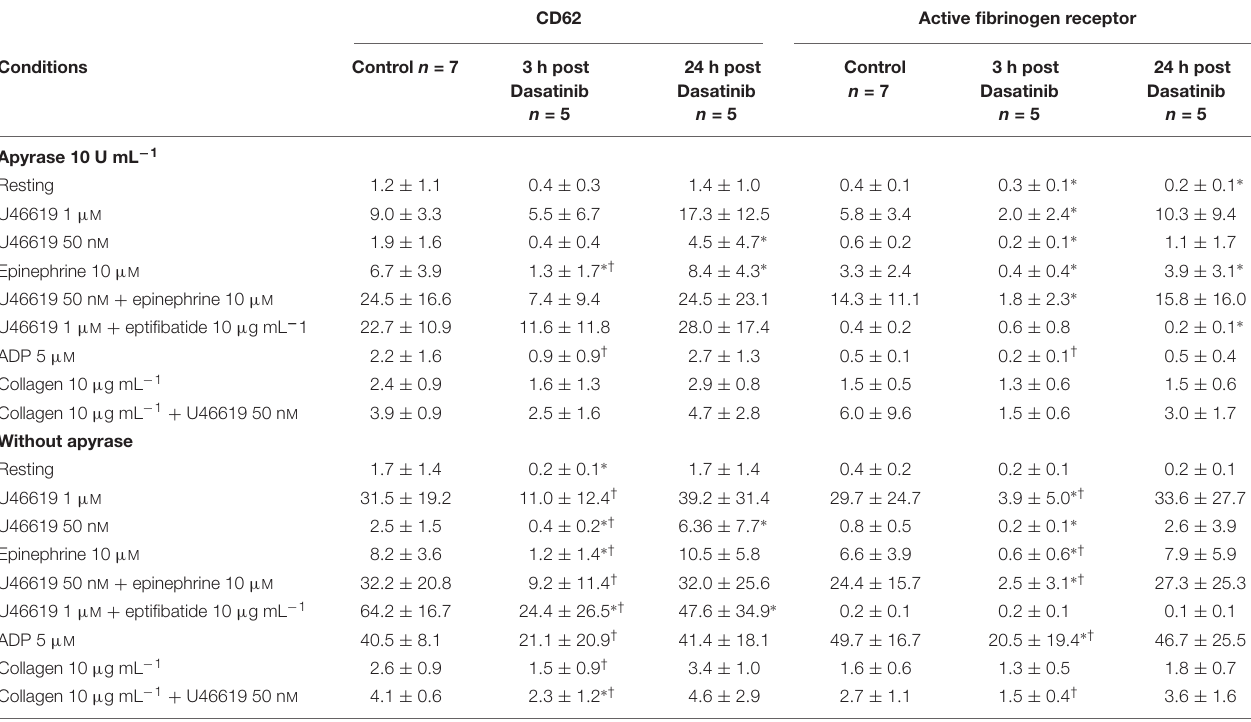
TABLE 2 | Ex vivo effect of dasatinib on the expression of P-Selectin (CD62%) and the active form of fibrinogen receptor (%). CD62 Active fibrinogen receptor